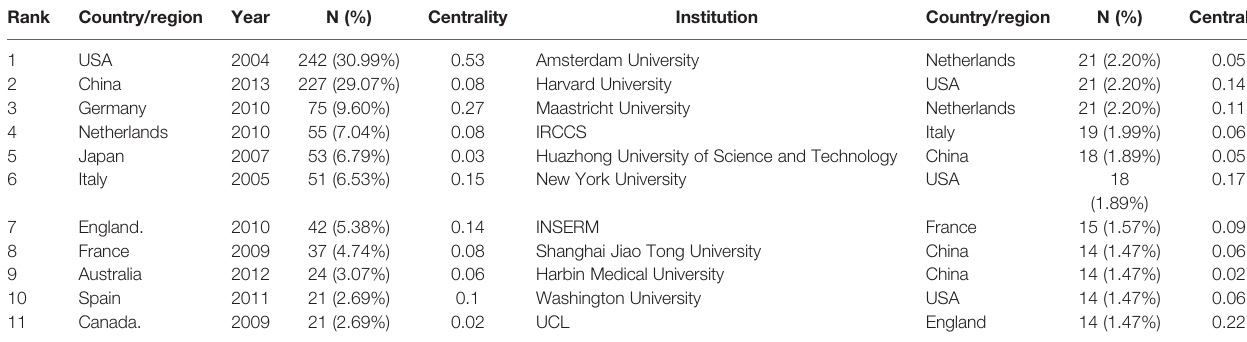
TABLE 2 | The top 10 countries/regions and institutions of macrophage polarization in